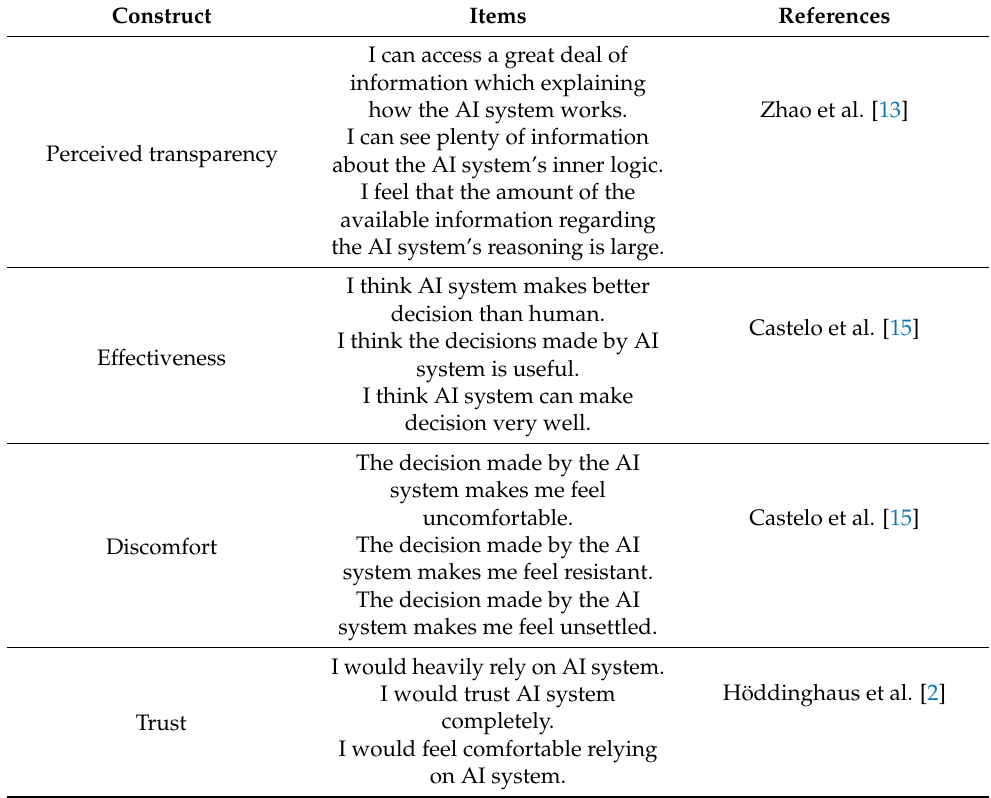
Table 1. Measurement items of each